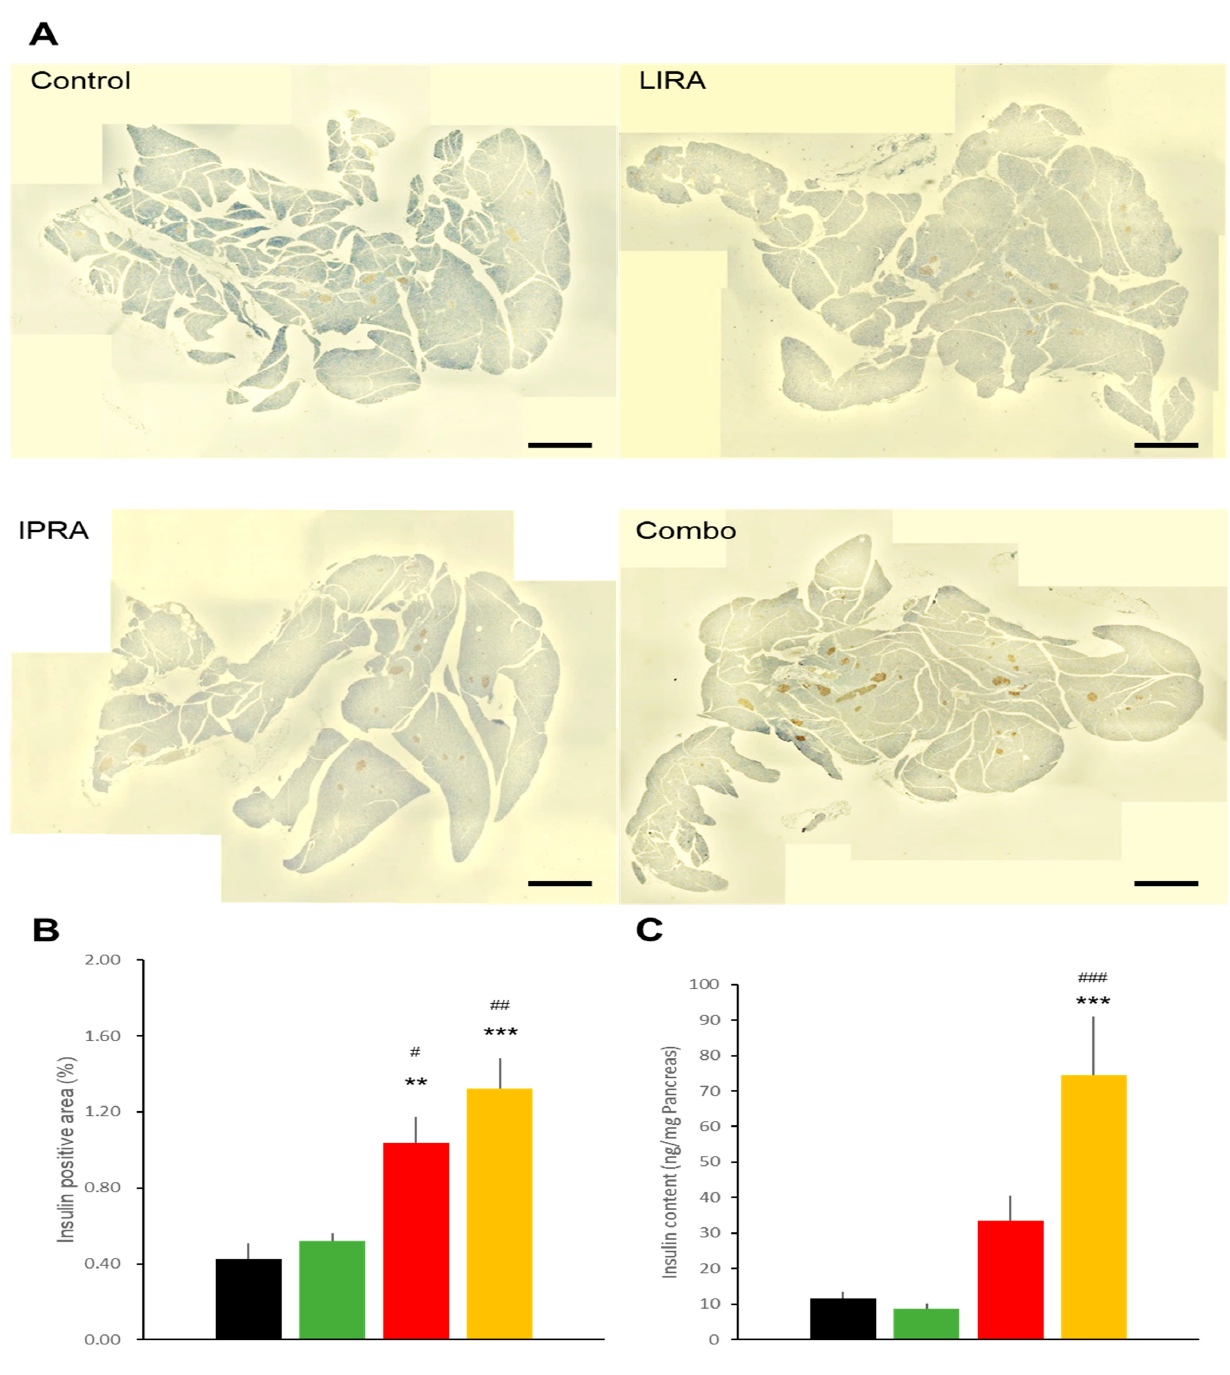
Figure 7. Effects of treatments with liraglutide and/or ipragliflozin on pancreatic islets in db/db mice. Representative pancreatic sections ( A ), insulin positive areas ( B ), and insulin contents ( C ) of vehicle-treated db/db mice and in db/db mice treated with liraglutide and/or ipragliflozin. Data represent mean ± SE, n = 6, ** p < 0.01, *** p < 0.001 vs. control group; ## p < 0.01, ### p < 0.001 vs. LIRA group. Scale bars = 500 μ m. An additional cohort of db/db mice was established, since insulin positive areas and insulin content cannot be obtained simultaneously from one mouse. Effects on glycemic control in this additional cohort did not differ from other cohorts.